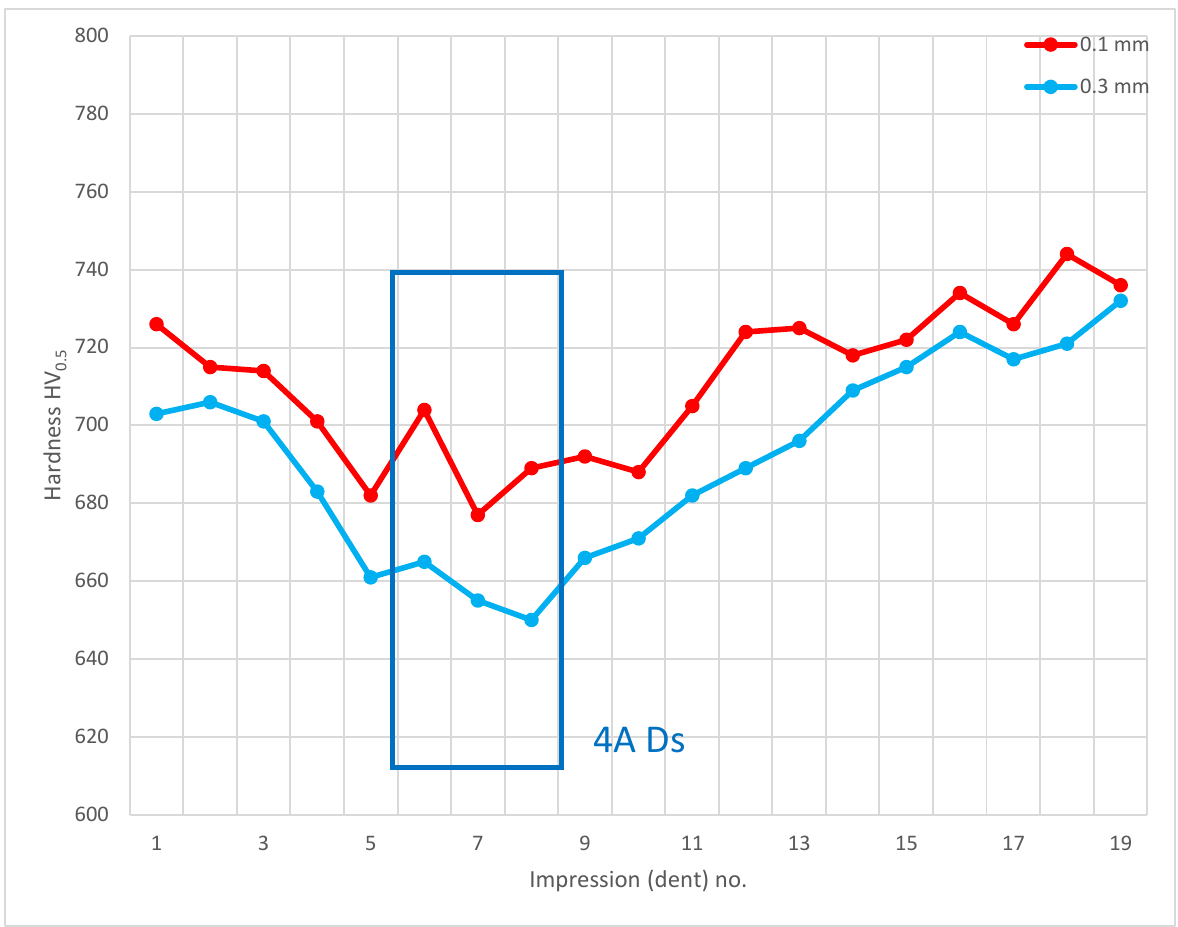
Figure 26. Microhardness measurement results. Paths depth (distance from tooth surface): 0.1 mm and 0.3 mm. Cross-section I-I, zone: 4A Ds.